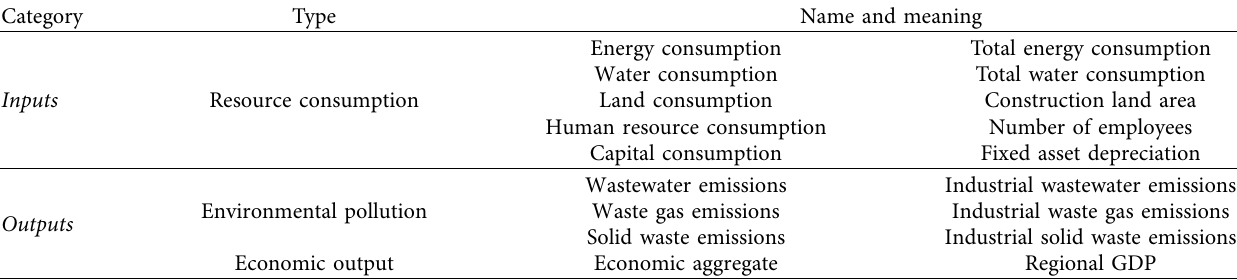
Table 1: Index system for environmental efficiency in Chinese section of the SREZ.